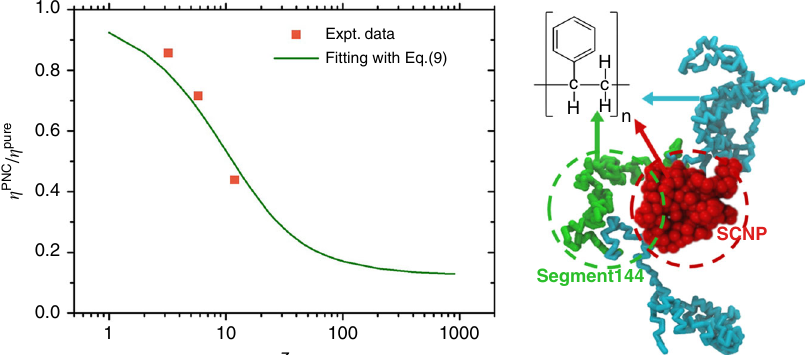
Fig. 8 Experimentally measured viscosity ratio between composites and pure PS melt, η PNC / η pure , plotted as a function of Z . The green line indicates a least squares fi tting of these data points using Eq. (9). On the right is a schematic depiction of the length scale of the interactions between SCNP (in red) with polymer chain. The entanglement blob which has a similar size with SCNP is plotted in green.